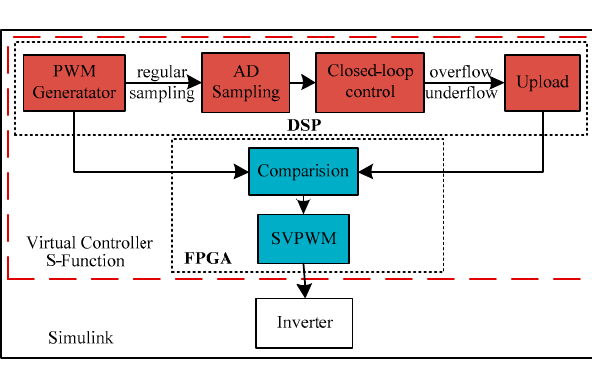
Figure 12. Sequence diagram of simulation system.